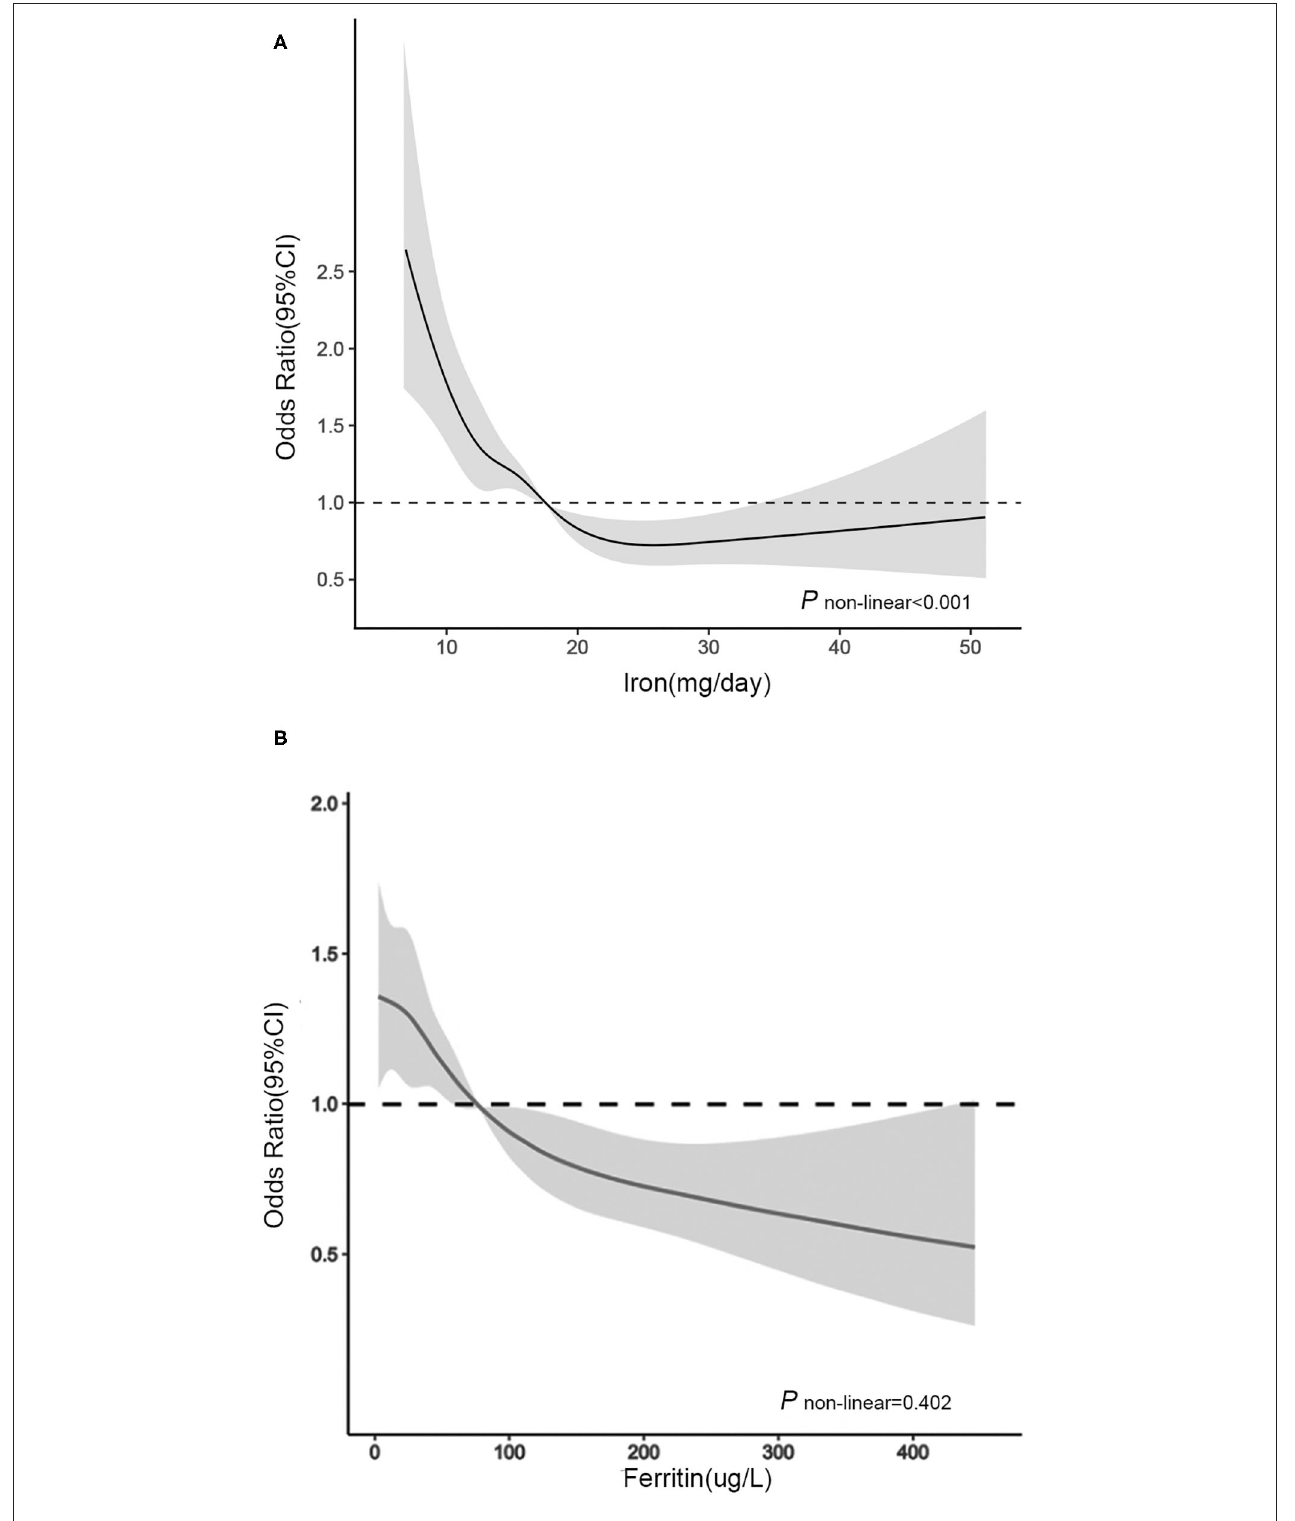
FIGURE 1 | Association between (A) dietary iron intake and (B) serum ferritin and headache in women of different ages in RCS. The model was adjusted for race/ethnicity, smoking, drinking, marital, education level, physical activity, BMI, energy intake, protein intake, carbohydrate intake, hypertension, diabetes, C reactive protein, total cholesterol, serum iron, hemoglobin, oral estrogen and birth control pills. Solid line, OR; shade, 95% CI.